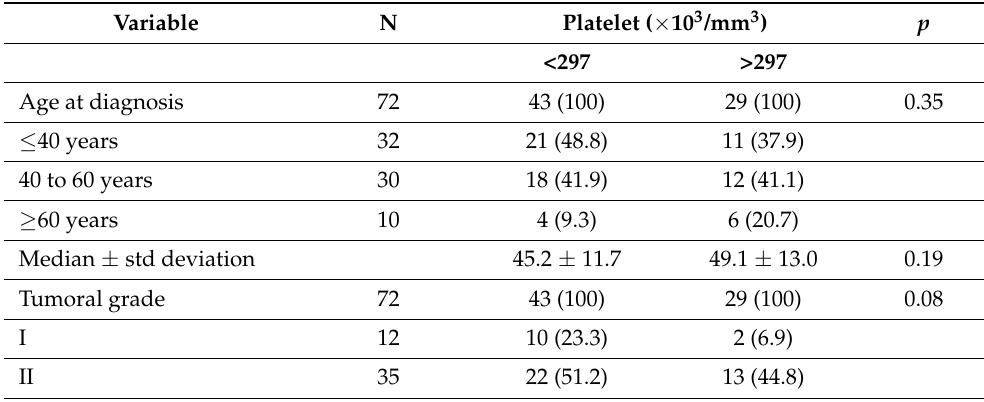
Table 2. Characteristics of patients according to platelet concentration—relapse